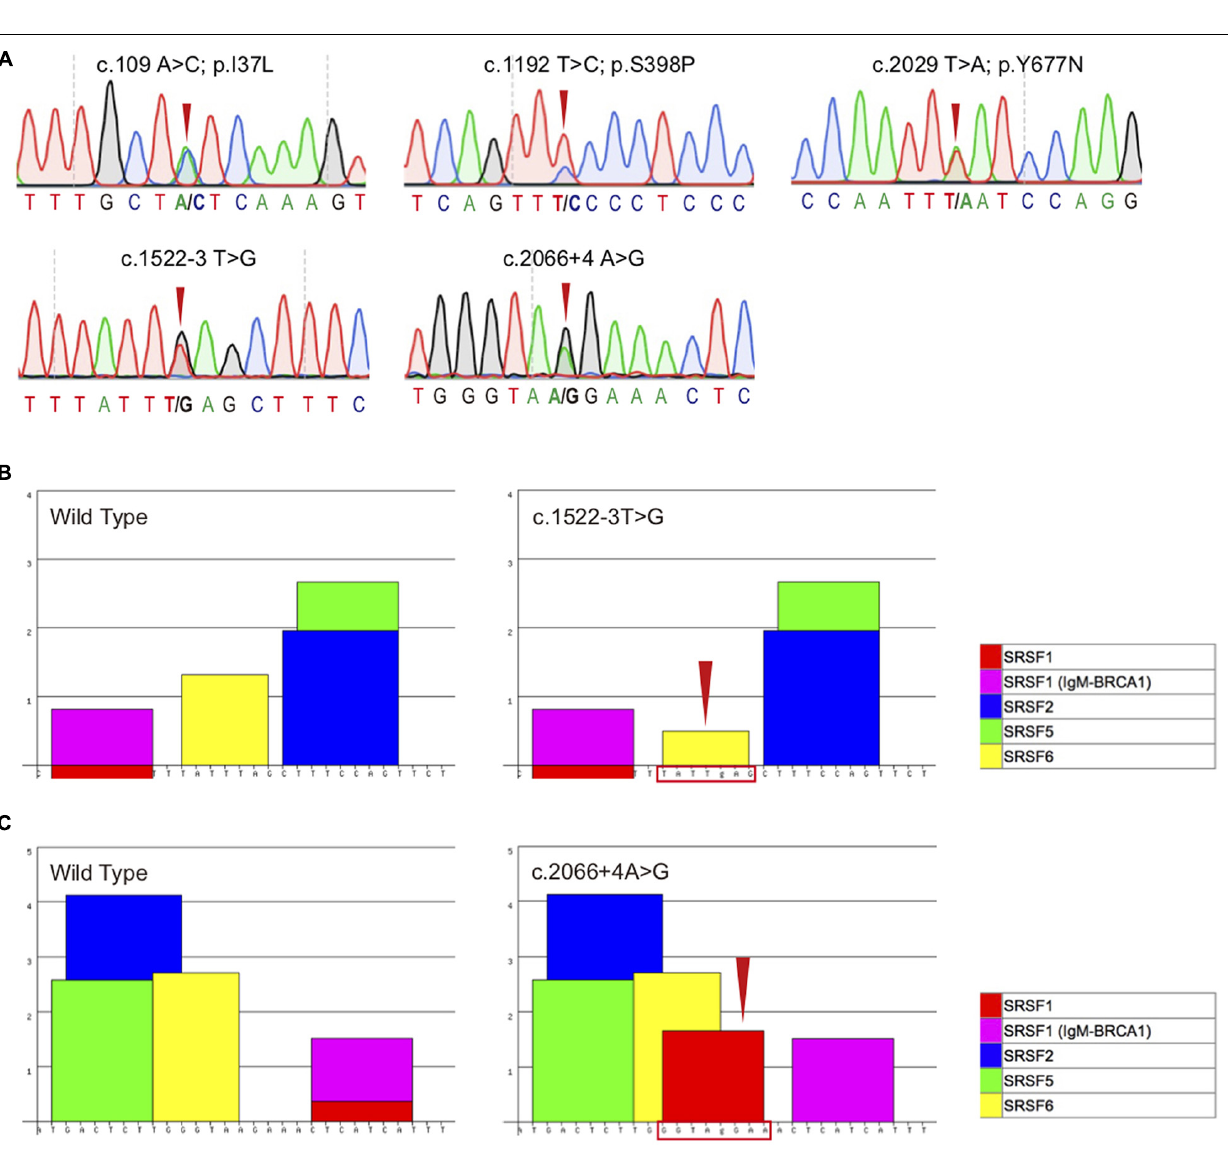
FIGURE 2 | Sequencing chromatogram and bioinformatics analysis of the TBK1 variants. (A) Sequencing chromatograms of the five TBK1 variants (c.109A > C, c.1192T > C, c.2029T > A, c.1522-3T > G and c.2066 + 4A > G) detected in this study. (B) Bioinformatics analysis of the wild type sequences and mutated sequences with the TBK1 c.1522-3T > G variant using ESEfinder 3.0, the program recognized that the TATTTAG (the binding site of SRSF6) (left) transformed to TATTgAG (right, indicated by red arrow and frame). (C) Bioinformatics analysis of the wild type sequences and mutated sequences with the TBK1 c.2066 + 4A > G variant using ESEfinder 3.0, the program recognized that a new motif GGTAgGAA (the binding site of SRSF1) was generated (right, indicated by red arrow and frame).